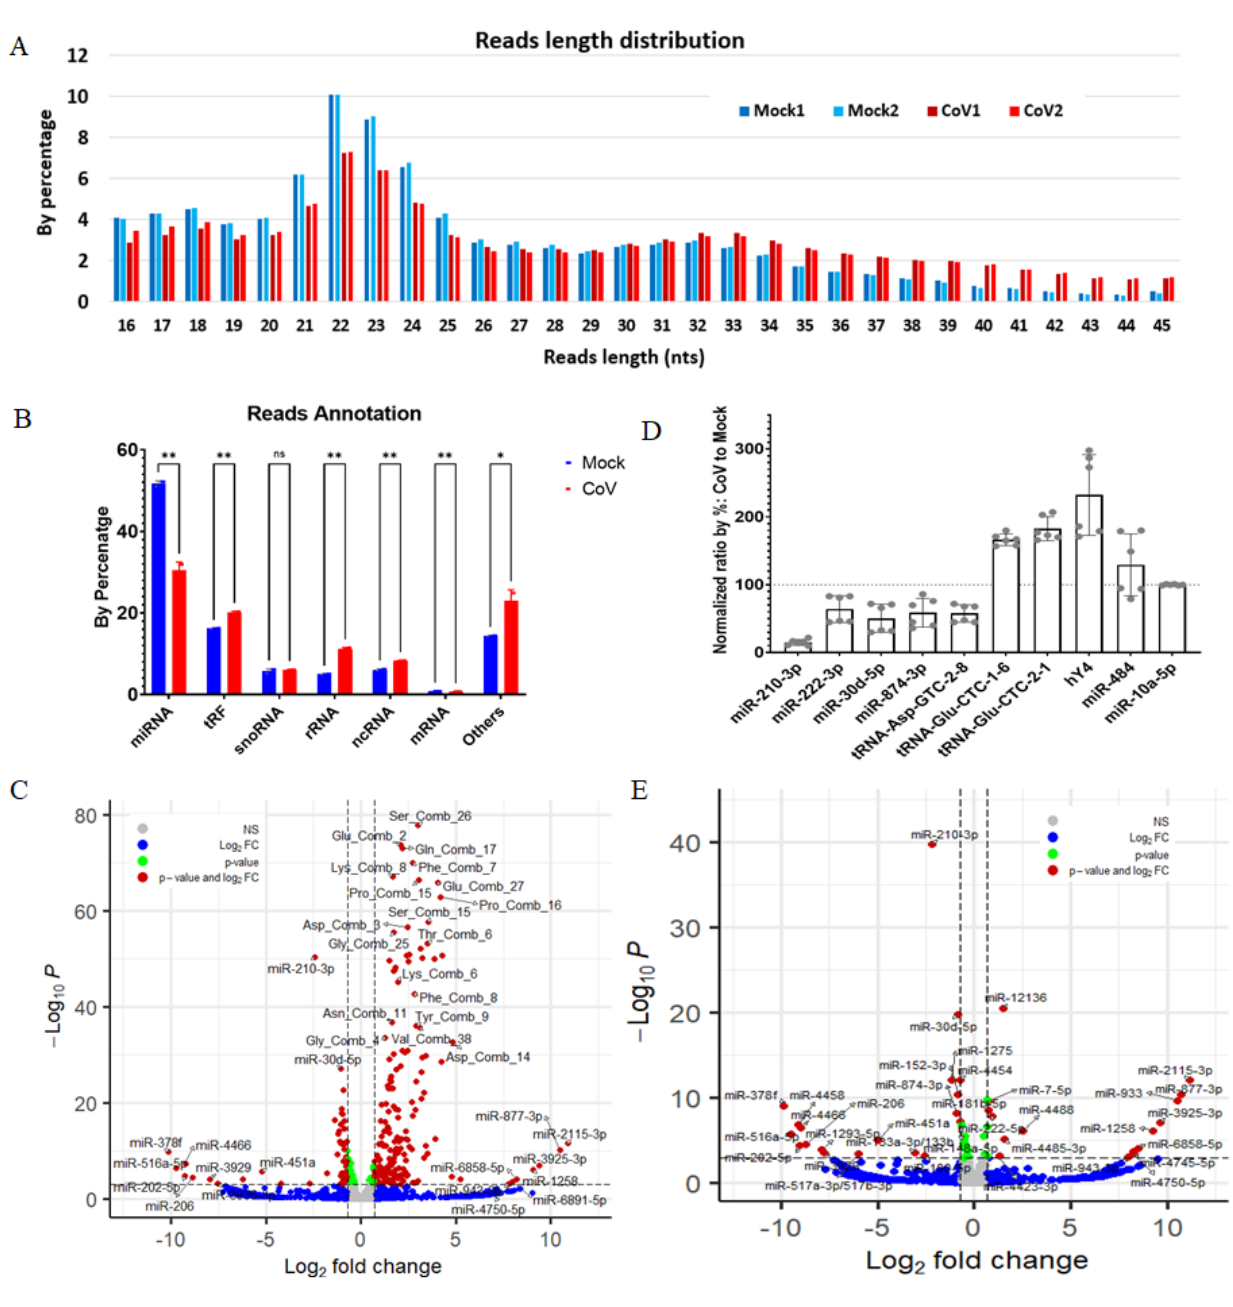
Figure 1. Summary of reads annotated as human small RNAs and plots of differentially expressed small RNAs in SARS-CoV-2-infected HEK293T-hACE2 cells versus mock-infected cells. ( A ) Small RNA read length distribution in mock or SARS-CoV-2 (CoV)-infected HEK293T-hACE2 cells analyzed by miRge3; ( B ) small RNA read annotation distribution in mock or SARS-CoV-2 (CoV)-infected HEK293T-hACE2 cells analyzed by miRge3 and statistics were performed with two-way ANOVA and followed by multiple unpaired t -tests; ( C ) volcano plot of differentially expressed host tRFs and miRNA in SARS-CoV-2-infected HEK293T-hACE2 cells versus mock-infected cells; ( D ) small